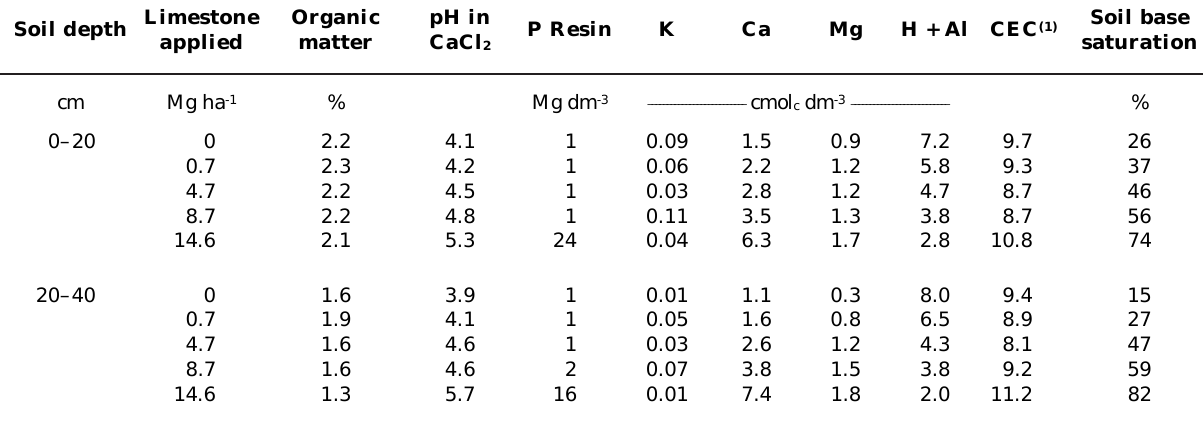
Table 1. Selected soil chemical characteristics of the plots, sixty days after liming. Pariquera-Açu, São Paulo,